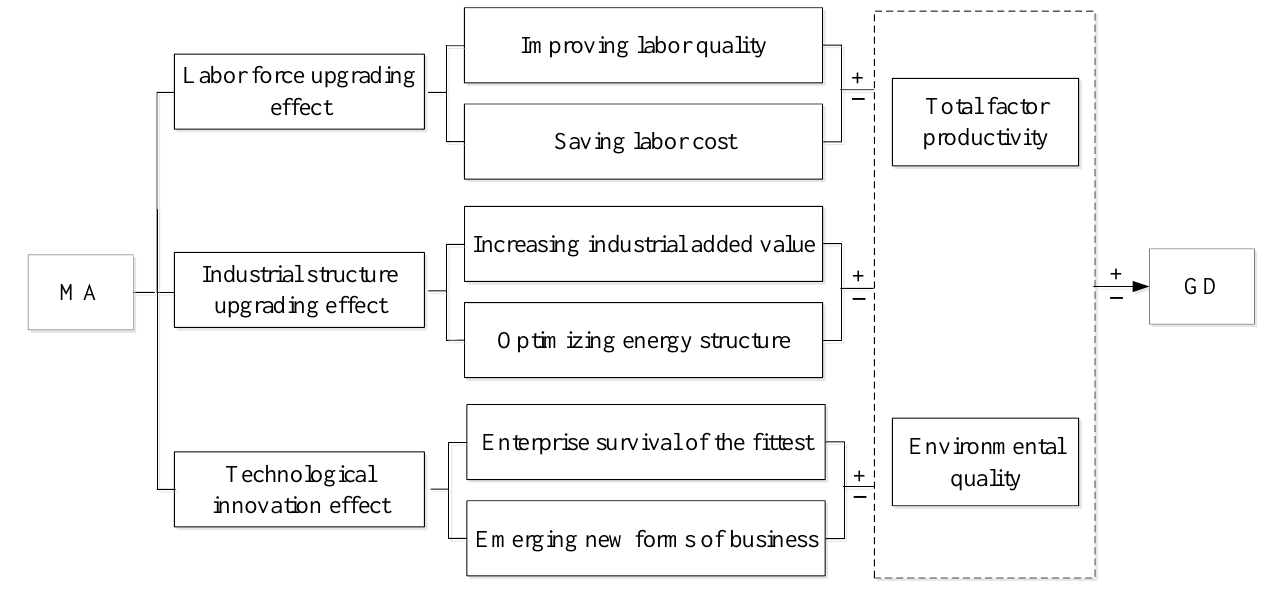
Figure 2. Indirect path of MA affecting GD.